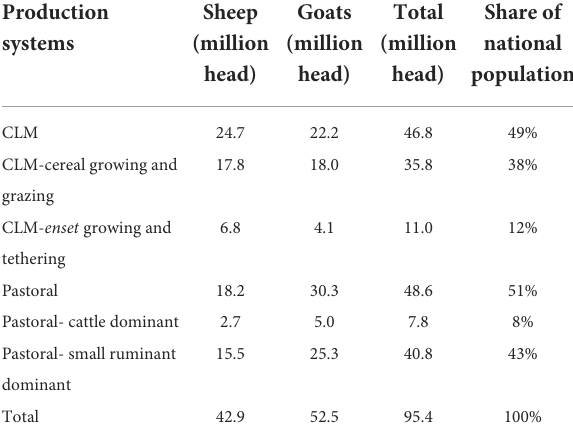
TABLE 2 Distribution of the small ruminant population by production system and species in